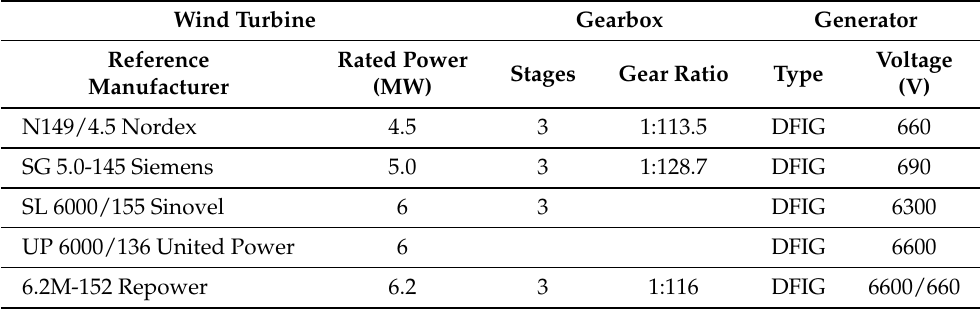
Table 4. Example of multi-megawatt variable speed with partial-scale frequency converter wind turbine